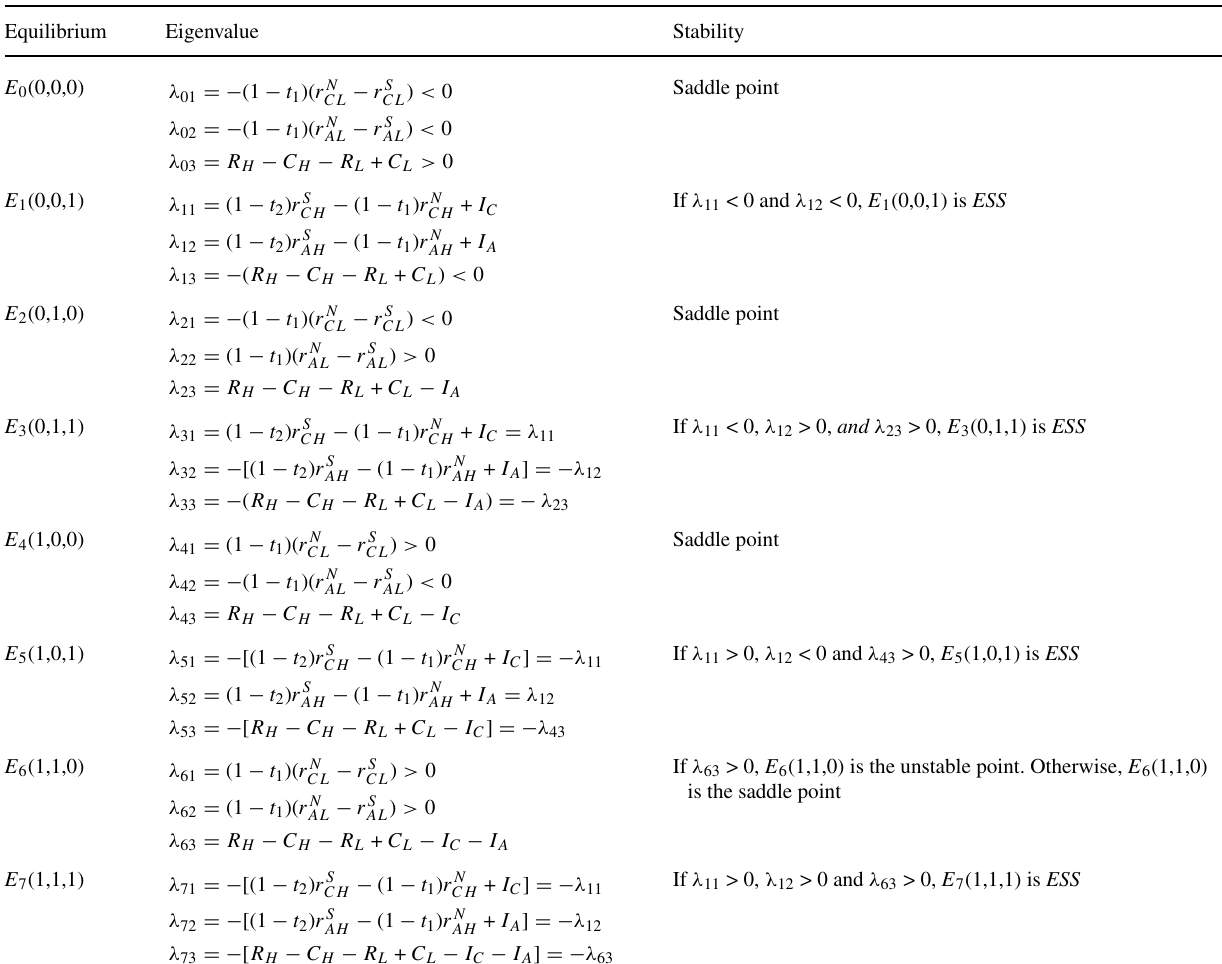
Table 3 Equilibrium point stability analysis Equilibrium